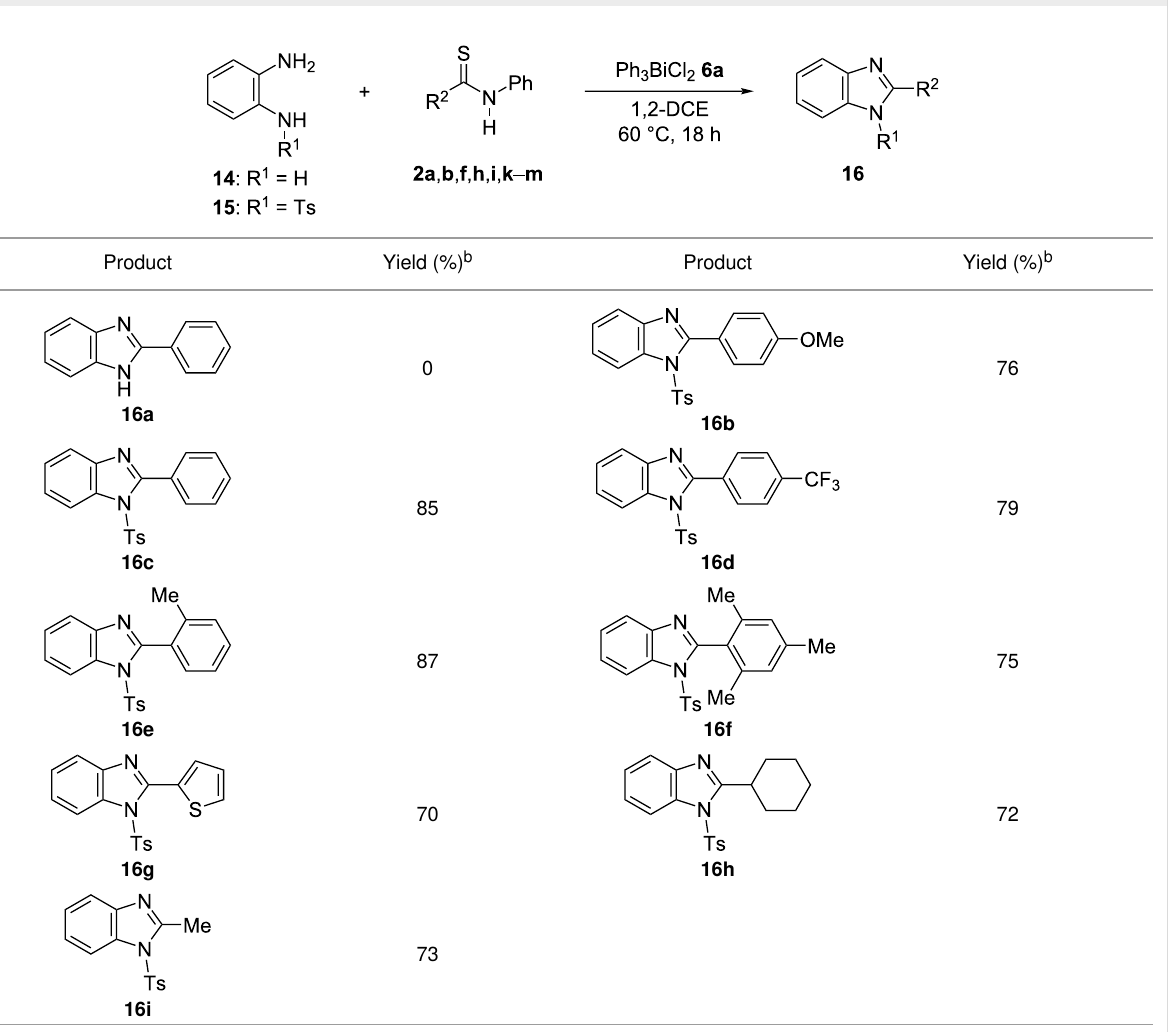
Table 3: Synthesis of 2-substituted N -tosylbenzimidazoles a